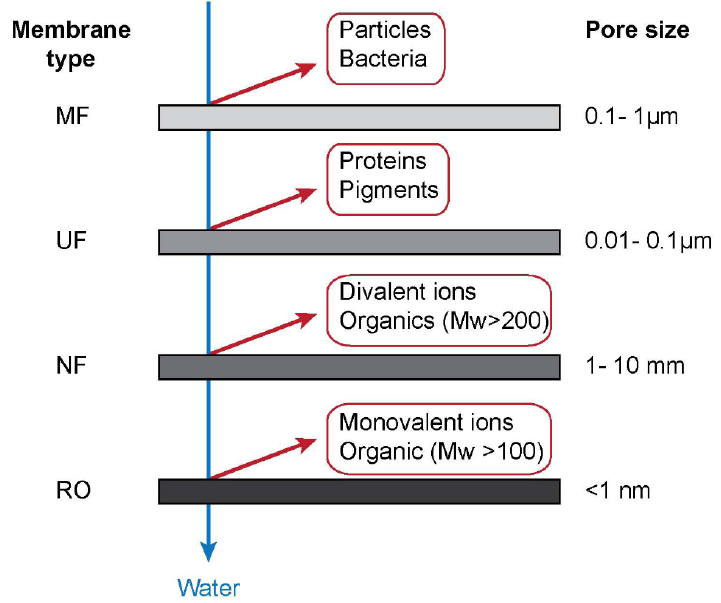
Figure 2. The classification of membranes, adapted from [19] .